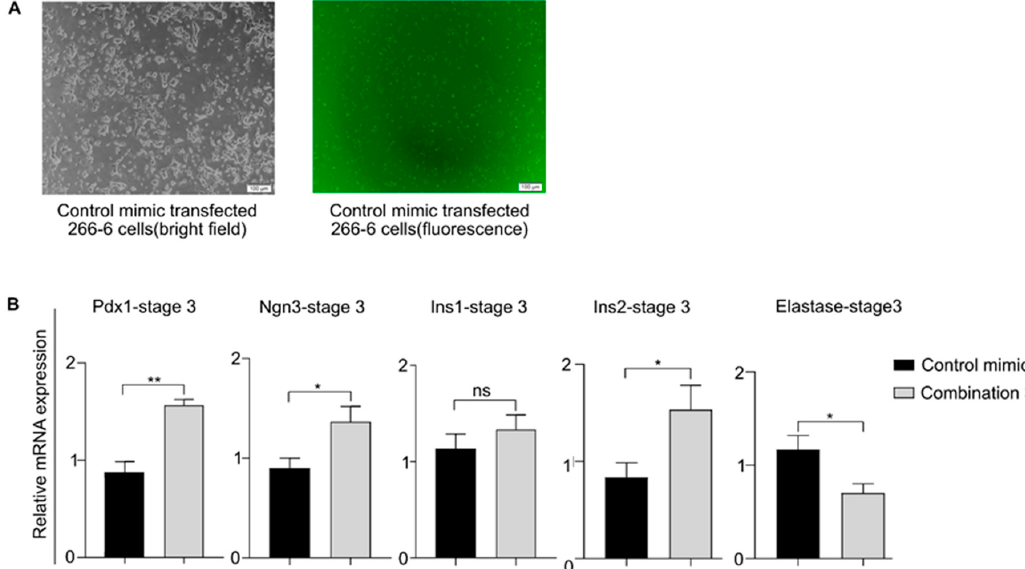
Figure 8. Transfection of miR-127 and miR-709 induces pancreatic β -cell gene expression in acinar cells. ( A ) Transfection optimization in 266-6 cells (acinar cell line) in stage 3 medium. The first panel represents a bright-field image of the 266-6 cells 48 h after transfection, and the second panel is the corresponding green channel (fluorescence microscope) image. Scale bar = 100 µm. ( B ) The acinar cell line (266-6) was transfected with miR-127 + miR-709 (combination 3), which increased the transcript